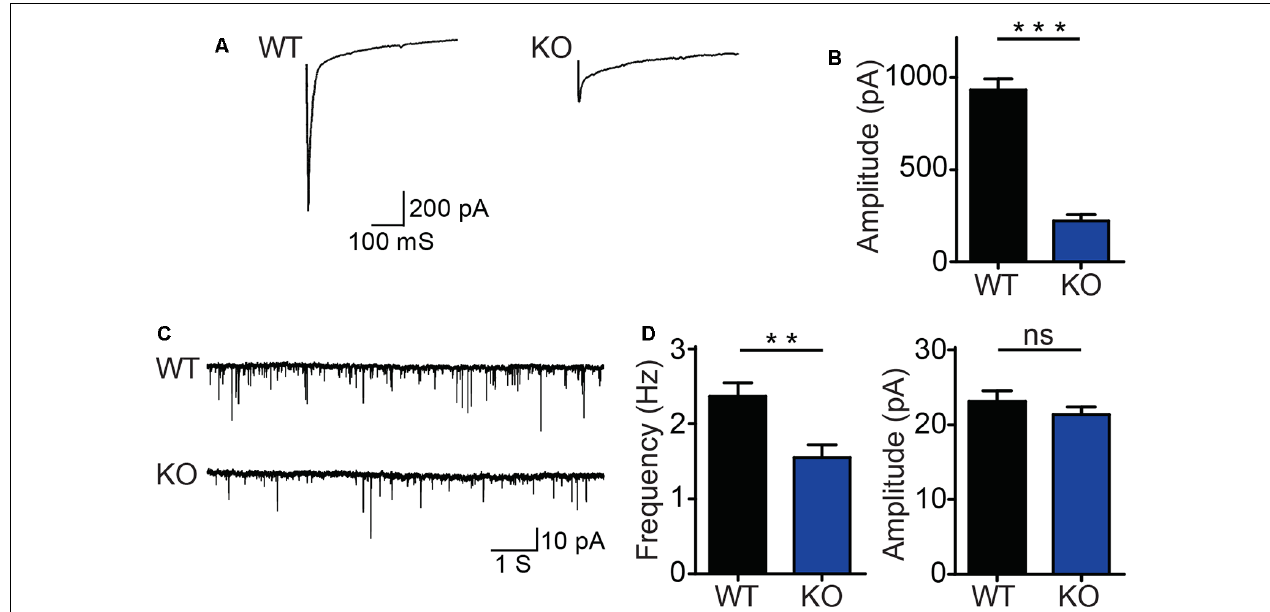
FIGURE 5 | DIP2B knockout inhibits synaptic transmission in hippocampal neurons. (A) Representative recordings of excitatory postsynaptic currents from WT and KO hippocampal neurons (WT, n = 10; KO, n = 10). (B) The average amplitude of EPSC recorded from panel (A) . (C) Representative recordings of excitatory spontaneous release from WT and KO mice (WT, n = 13; KO, n = 14). (D) Average frequency (left) and amplitude (right) of mEPSC recorded. An unpaired t- test was used for comparisons. ns, not significant; ** p < 0.01; *** p < 0.001; n, cell number. Error bars represent SEM. For further details, see Supplementary Table S1